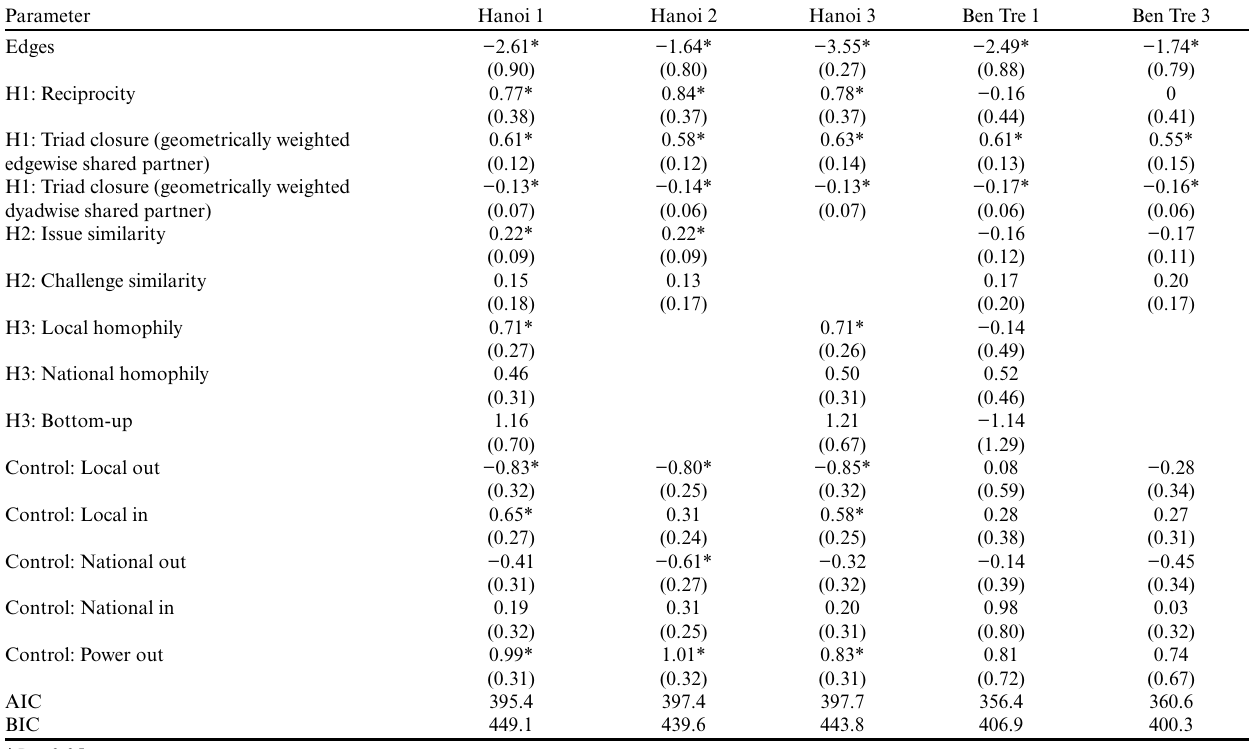
Table 1. Results of exponential random graph models. Parameter values represent conditional log-odds, and values in brackets are standard